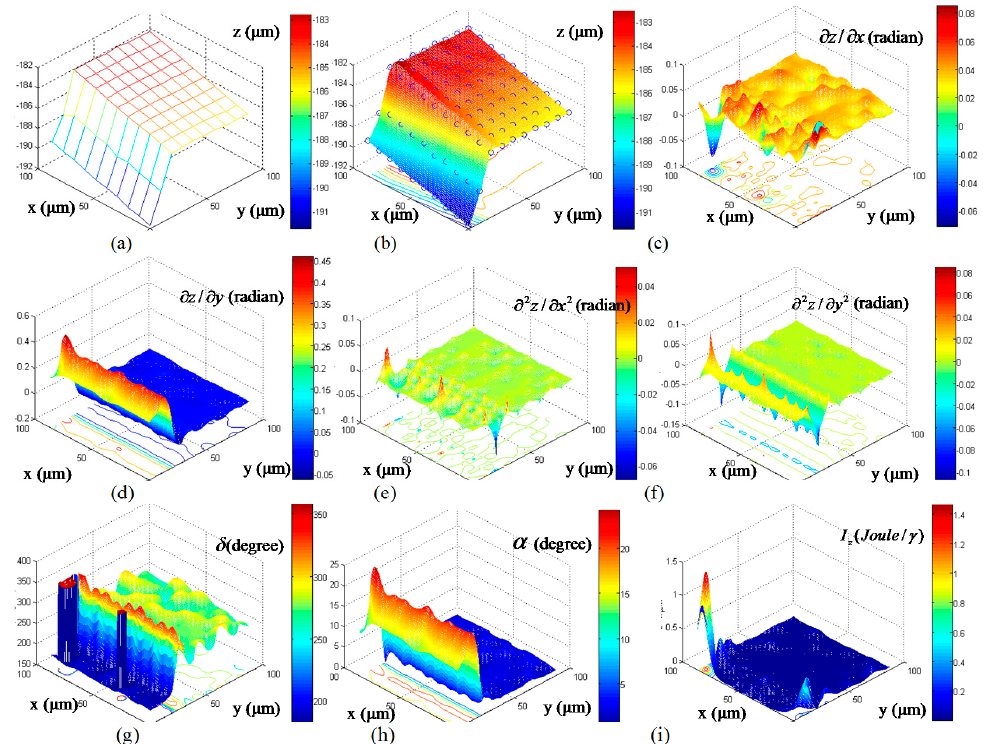
Figure 9. Isometric views of: ( a ) Measured micro-surface; ( b ) Reconstructed micro-surface; ( c ) Interpolated slope micro-surface in x -direction; ( d ) Interpolated slope micro-surface in y -direction; ( e ) Interpolated curvature micro-surface in x -direction; ( f ) Interpolated y -direction curvature; ( g ) Interpolated micro-surface of strike angles; ( h ) Interpolated micro-surface of dip angles; ( i ) Interpolated bending energy micro-surface.